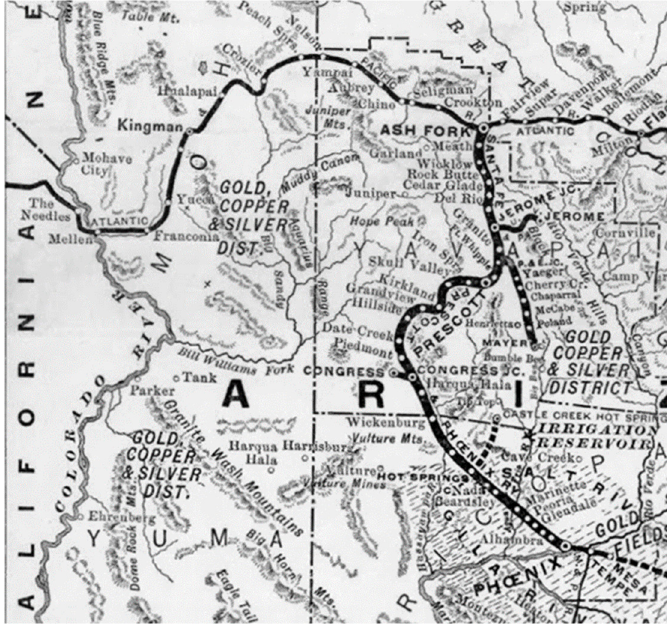
Figure 14. Ash Fork showing rail corridors (with transfer at Phoenix to Tempe).